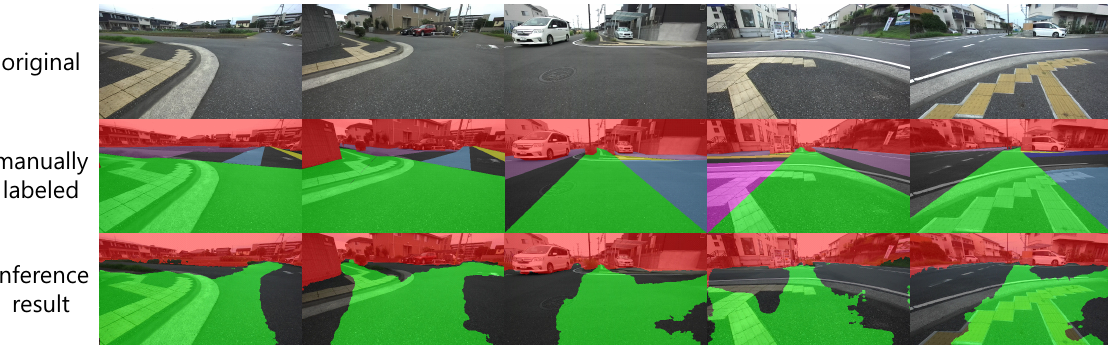
Figure 19. Inference results of trained model after loss weight adjustment with 50 × 225 + 400 × 50